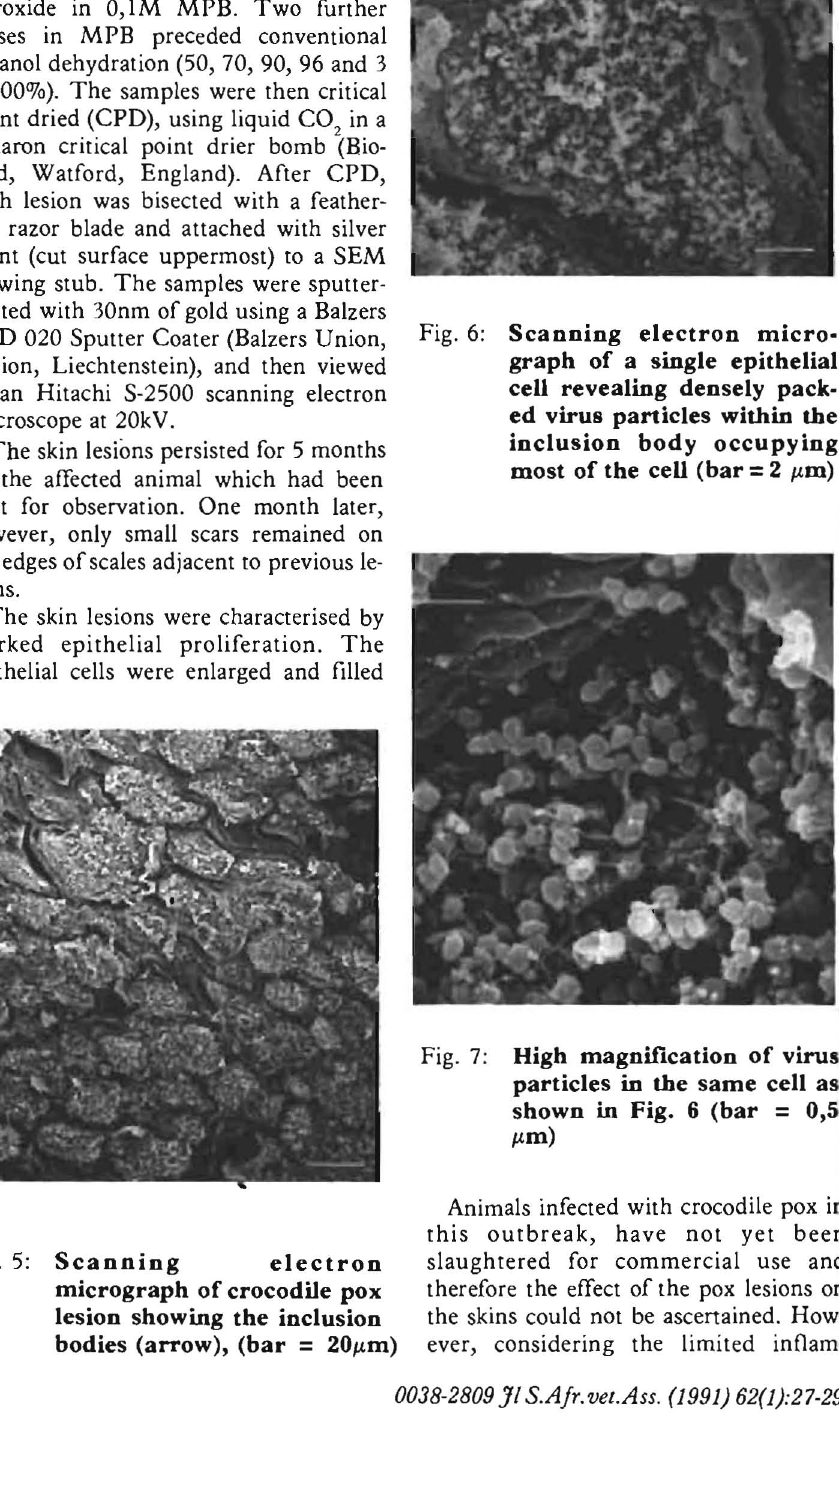
Fig. 3: Pox lesions on the lateral surface of the tail of a croco dile. Lesions situated in a straight line (arrow) suggest